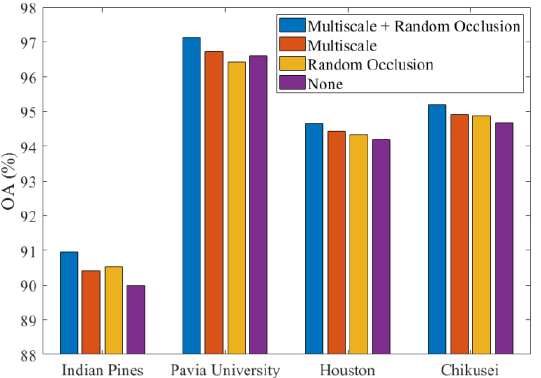
Figure 22. The overall accuracy of SCL using different data augmentation techniques.